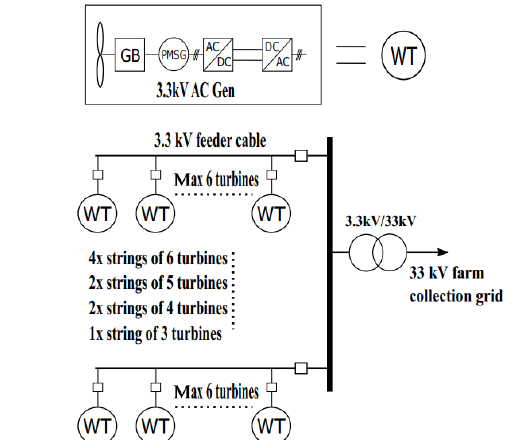
Figure 6. AC radial topology.